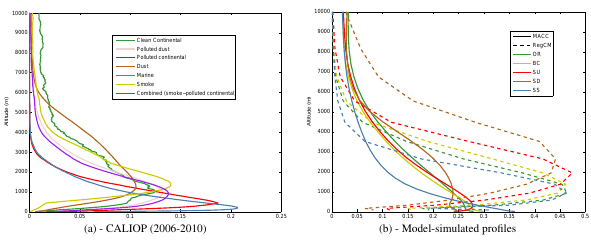
Fig.9. MeanaerosoltypeverticalprofileovertheMediterraneanbasin. CALIOP(2006-2010)ontheleft,model-simulatedproductsonthe right(MACCincontinuousline,RegCM-4indashedline). Fig. 9. Mean aerosol type vertical profile over the Mediterranean basin. CALIOP (2006–2010) on the left, model-simulated products at 900 m) and sulfate (1900 m) aerosols are also higher in on the right (MACC in continuous line, RegCM-4 in dashed RegCM-4 than in MACC (resp. at surface and 300 m) and CALIOP,comparedrespectivelytomarineandpollutedcon- 1015 tinentalaerosols. Onthecontrary,blackcarbonaerosolsare lower in MACC where maximum is at surface compared to RegCM-4(1400m)andCALIOPsmoke(1300m)andpol- luted continental (400 m). As a result, several differences havebeenshownbetweenCALIOPandbothmodels,sothat 1020 we choose to keep CALIOP profiles for our reconstruction: marine (for SS), dust (for SD) and the combination of pol- lutedcontinentalandsmoke(forOR,BCandSU).Theques-